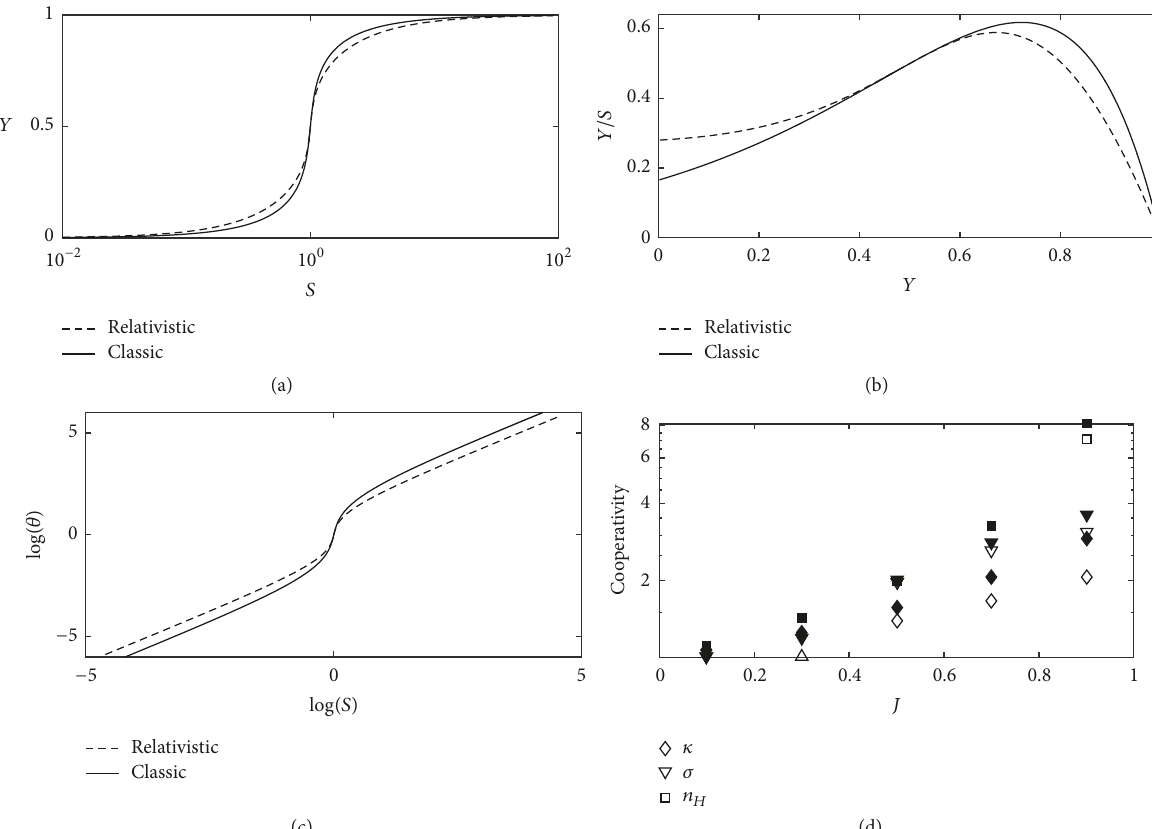
Figure 2: Summary of analysis on cooperativity . (a) Klotz plot showing the saturation function 𝑌 versus the substrate concentration 𝑆 (notice the logarithmic scale on the 𝑥 -axis) for the relativistic (dashed line) and the classical (solid line) models. Data for 𝑌 are collected by solving numerically the self-consistent equations ((39) and (22), resp.) for 𝐽 = 0.9 and different values of 𝑆 . Both models exhibit the sigmoidal shape typical of cooperative systems; however, the former displays a slower saturation. Analogous results are obtained for different values of 𝐽 > 0 . (b) A Scatchard plot is built with the same collection of data by showing the ratio 𝑌/𝑆 versus 𝑌 . Both models exhibit the concave-down shape typical of cooperative systems. However, for relatively small values of 𝐽 the plot for the relativistic model is monotonically decreasing (see also Figure 3). (c) A Hill plot is built with the same collection of data by showing 𝜃 = 𝑌/(1 − 𝑌) versus 𝑆 ; both observables are taken under the logarithm. When 𝑆 is close to one (here 𝑆 0 = 1 ) the relativistic and the classical model give overlapped curves, while when 𝑆 is either very large or very small the two curves are shifted. (d) By further analyzing the plots in the previous panels we can derive estimates for the extent of cooperativity characterizing the systems. As explained in the main text, starting from data in (a) we measured the Kloshand quantifier 𝜅 = 𝑆 /𝑆 ⬦ ), by extrapolating the maximum value for data in (b) we get 𝜎 ( ∇ ), and by fitting the data in (c) at the half-saturation point 0.9 0.10 ( we get 𝑛 𝐻 ( ◻ ). These estimates are obtained for both the relativistic (white symbol) and the classic (black symbols)